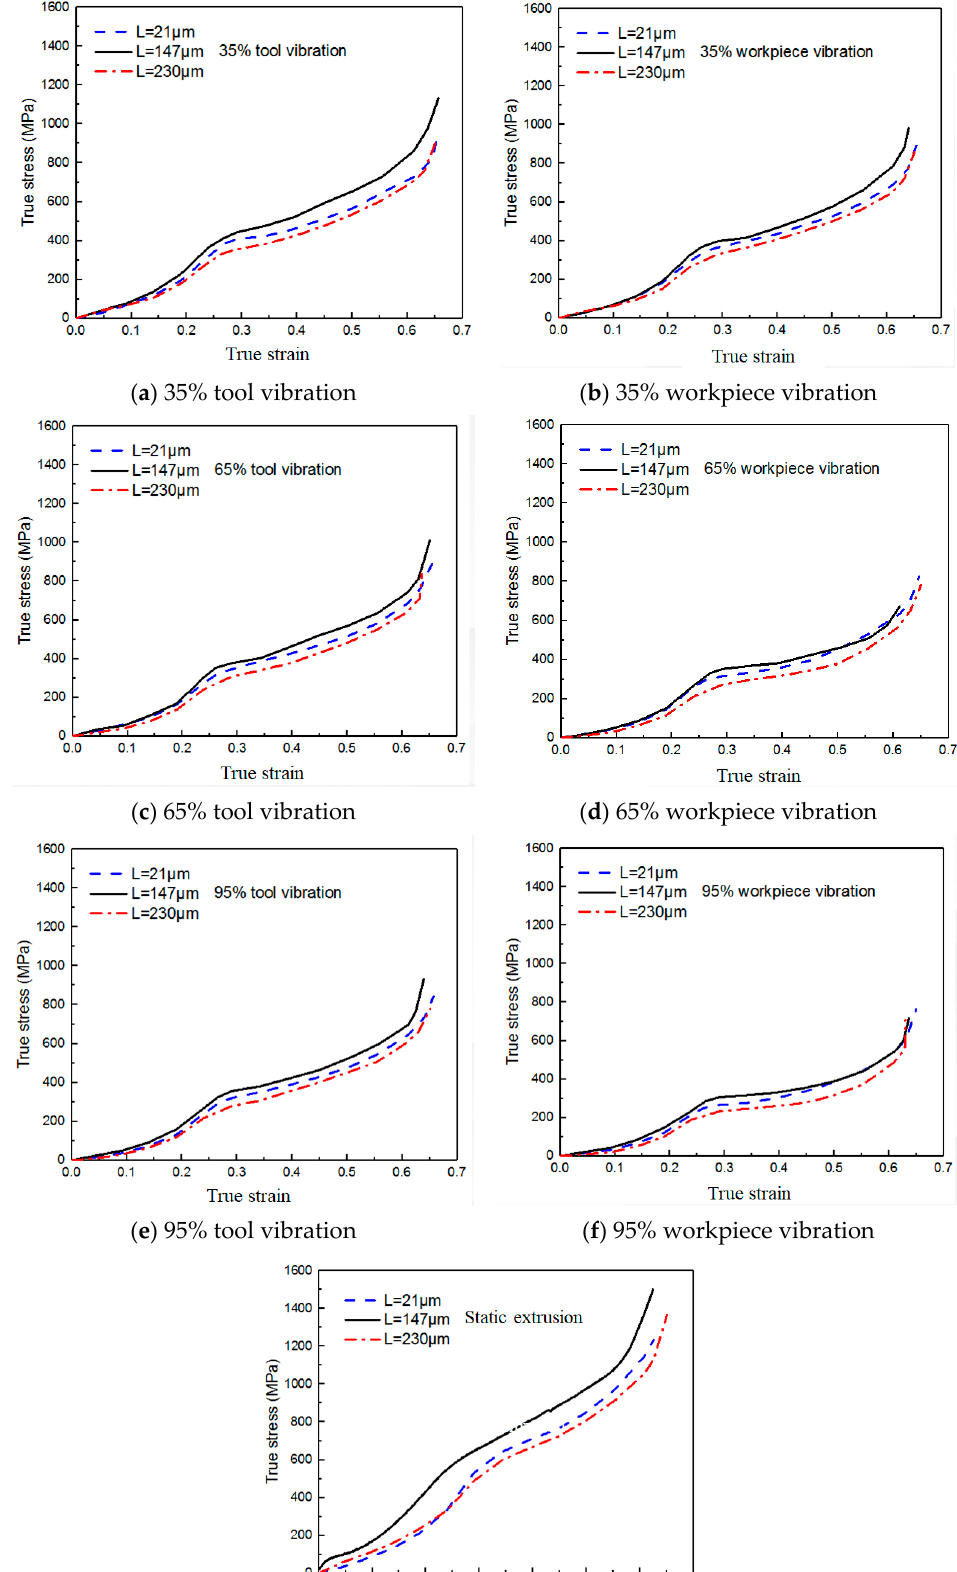
Figure 9. True stress and true strains with different initial grain sizes.